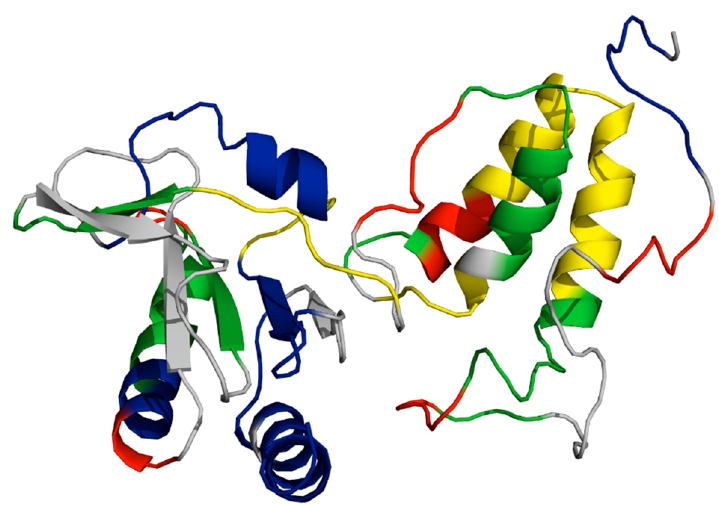
Figure 4. A predicted model of TraF, known to be required for F pilus extension beyond the OM. The model is colored based on observed rates of hydrogen-deuterium exchange (HDX) of main-chain amide hydrogens by time resolved HDX mass spectrometry [86]. Rates of exchange are colored as: red = high, yellow = high − moderate, green = moderate − low, blue = low. The C-terminal domain (CTD) (left side of the figure) contains a thioredoxin-like motif and exhibits low HDX, indicating a well-structured domain. The N-terminal domain (NTD), predicted to be responsible for interaction with TraH, is much more dynamic, as exhibited by increased HDX. Further analysis is required to pinpoint structural features responsible for F pilus extension and examine the changes in protein structure and dynamics upon TraF’s interaction with TraH.